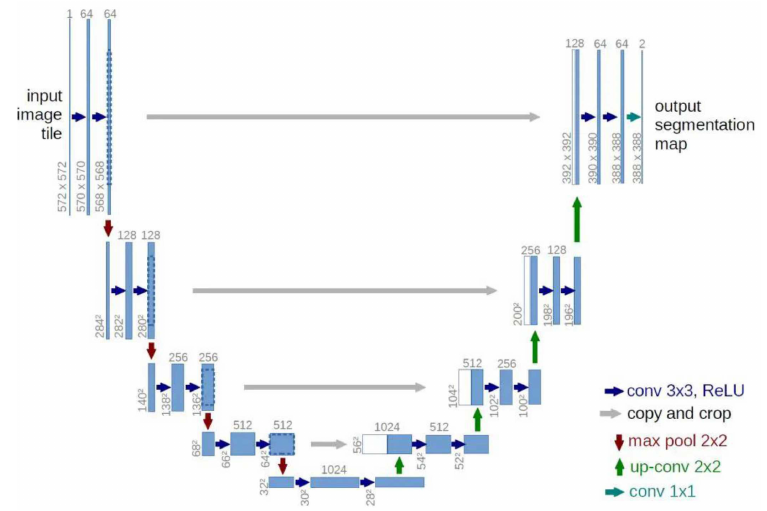
Figure 2. U-Net model [10]: classical symmetric codec structure with feature concatenate.